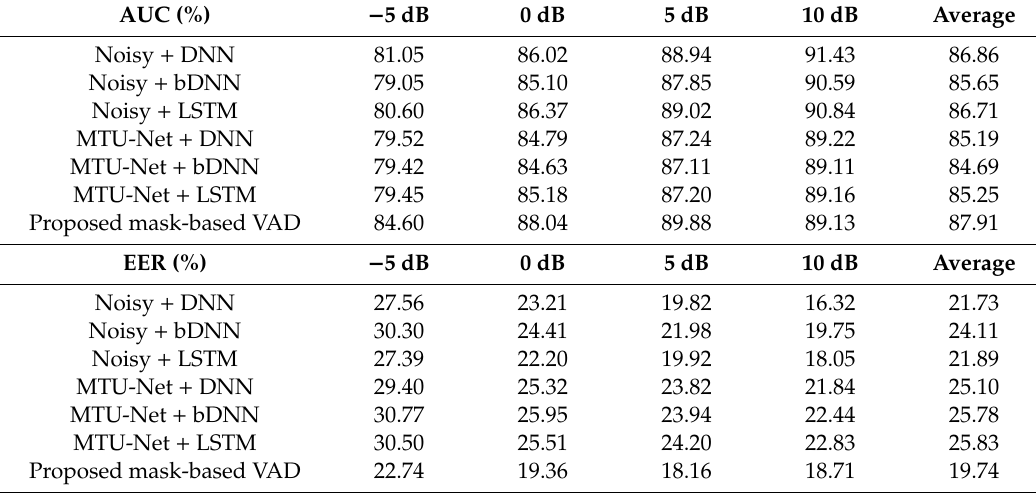
Table 5. Comparison of the AUCs (%) and EERs (%) of the seven di ff erent voice activity detection methods according to their di ff erent signal-to-noise ratios under mismatched